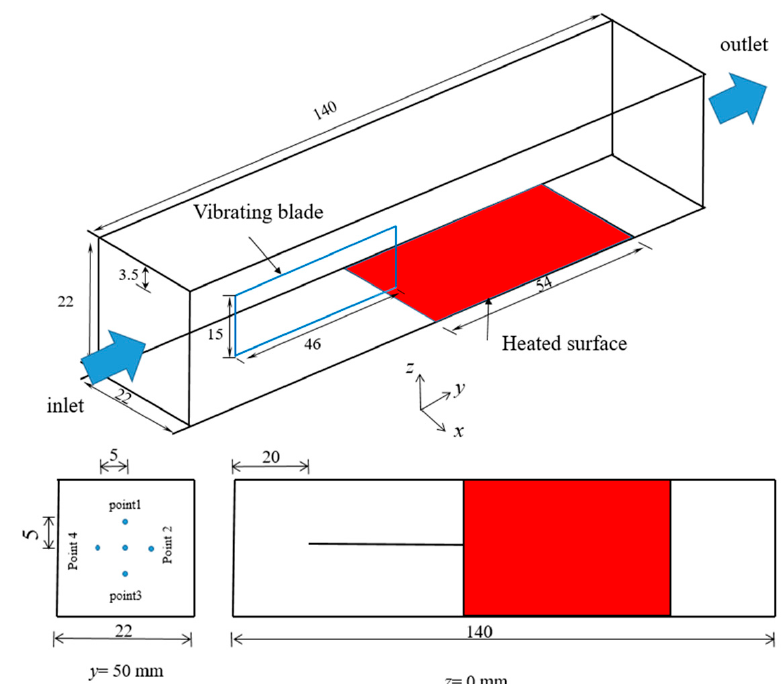
Figure 1. Computational